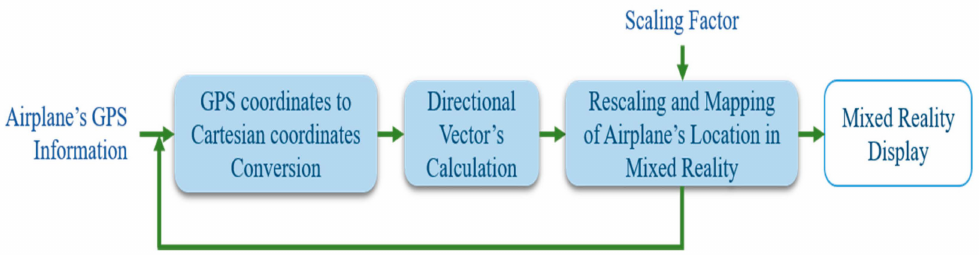
Figure 8. The execution order for process of mapping an airplane’s location in a mixed reality